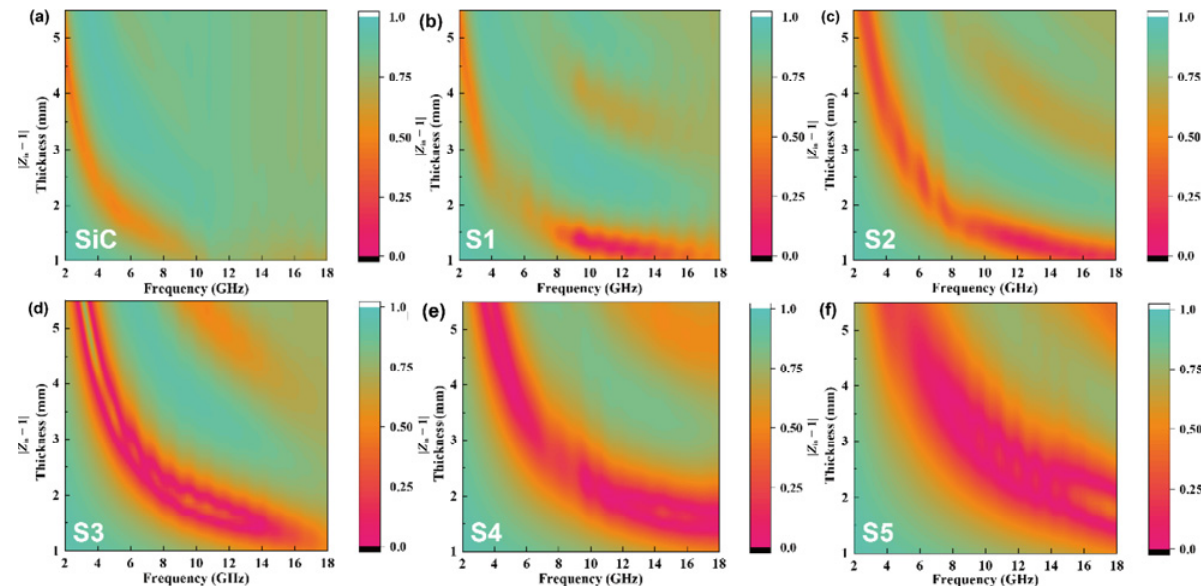
Fig. 6 | Z in − 1| of (a) pure SiC aerogel, (b) S1, (c) S2, (d) S3, (e) S4, and (f)